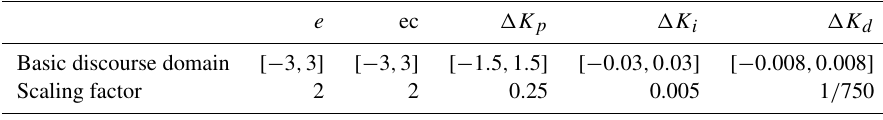
Table 1. Basic data after fuzzification.